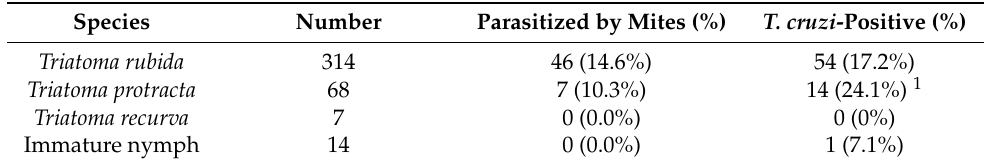
Table 1. Mite parasitization and T. cruzi infection rates of Triatoma sp. collected in Arizona and New